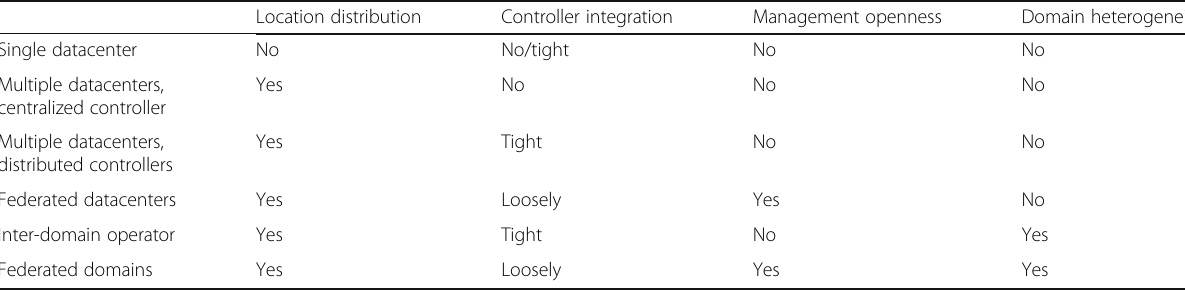
Table 1 Primary clusters of the SDN literature based on the proposed model Location